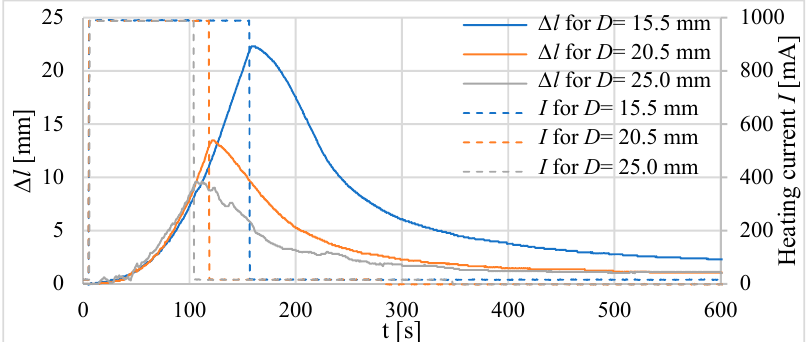
Figure 10. Elongation of tube actuators with equal volumes of composite and different diameters.